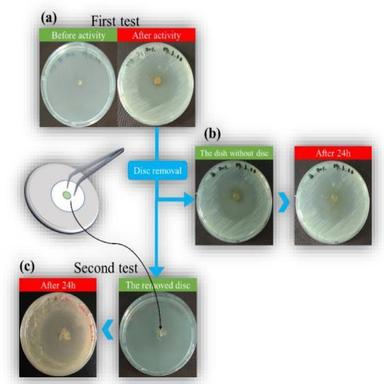
Digital images of antibacterial test for AMO2@BENT material against MRSA bacteria strain (a) first test; (b) Petri dish of the first test incubated without disc; (c) the second or reuse test.